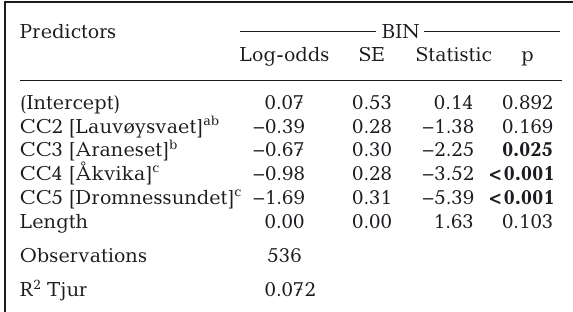
Table 4. Binomial model for the likelihood of cod being de - Table 3. Results of linear mixed effect on the influence tected at a salmon farm depending on the categorical variable of salmon farm operational status (SIF), day or night (catch cluster, CC) and fish length. The treatment contrast of R (DAY_NIGHT) and fish length (LENGTH, cm) on cod depth. was used with the intercept representing the value for Gla - The treatment contrast of R was used with the intercept rep- søysvaet (CC1). Square brackets indicate a categorical variable resenting the value for a non-operational farm during the tested against the reference variable. Letters show the re sults day. Square brackets indicate a categorical variable tested against the reference variable. Significant p-values are in bold (p < 0.05). Only fixed effects are shown